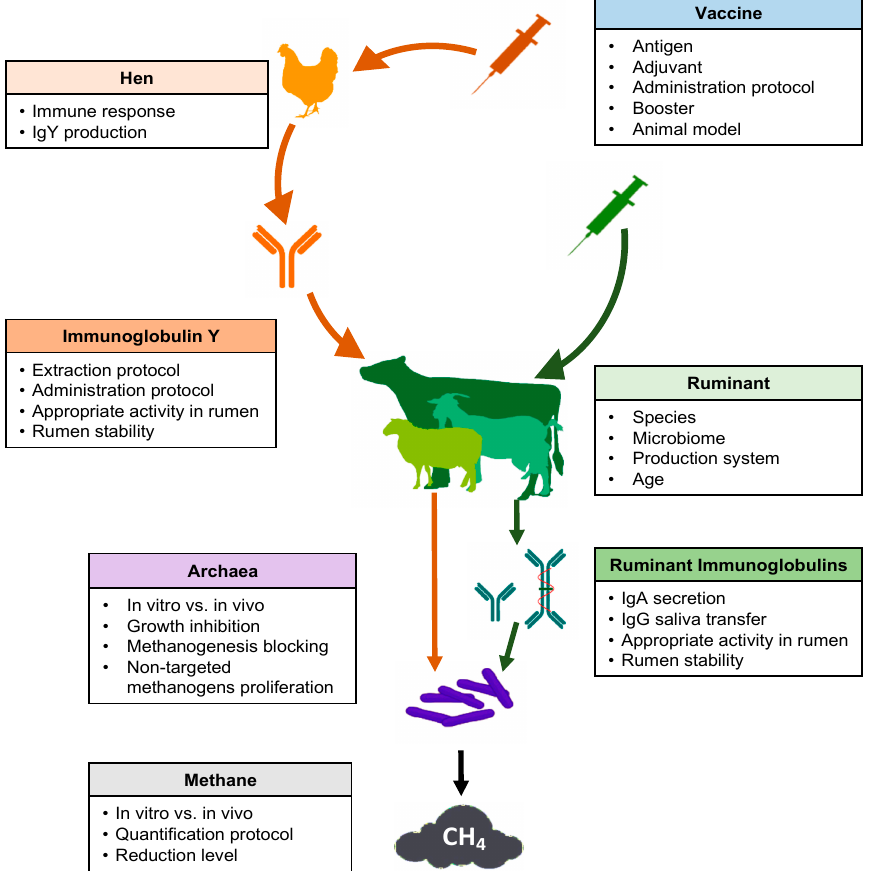
Figure 1. Schematic overview of key points to consider for the use of vaccines to decrease methane emissions from ruminal fermentation.